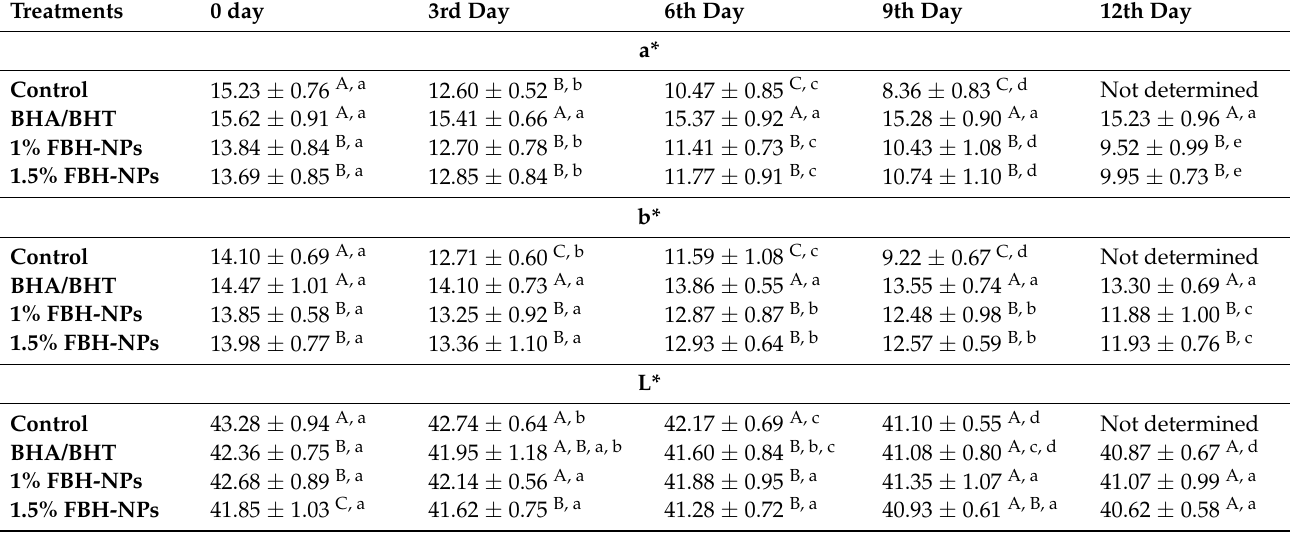
Table 3. Effect of adding FBH-NPs on colour parameters (L*, a* and b*) of burgers during refrigerated